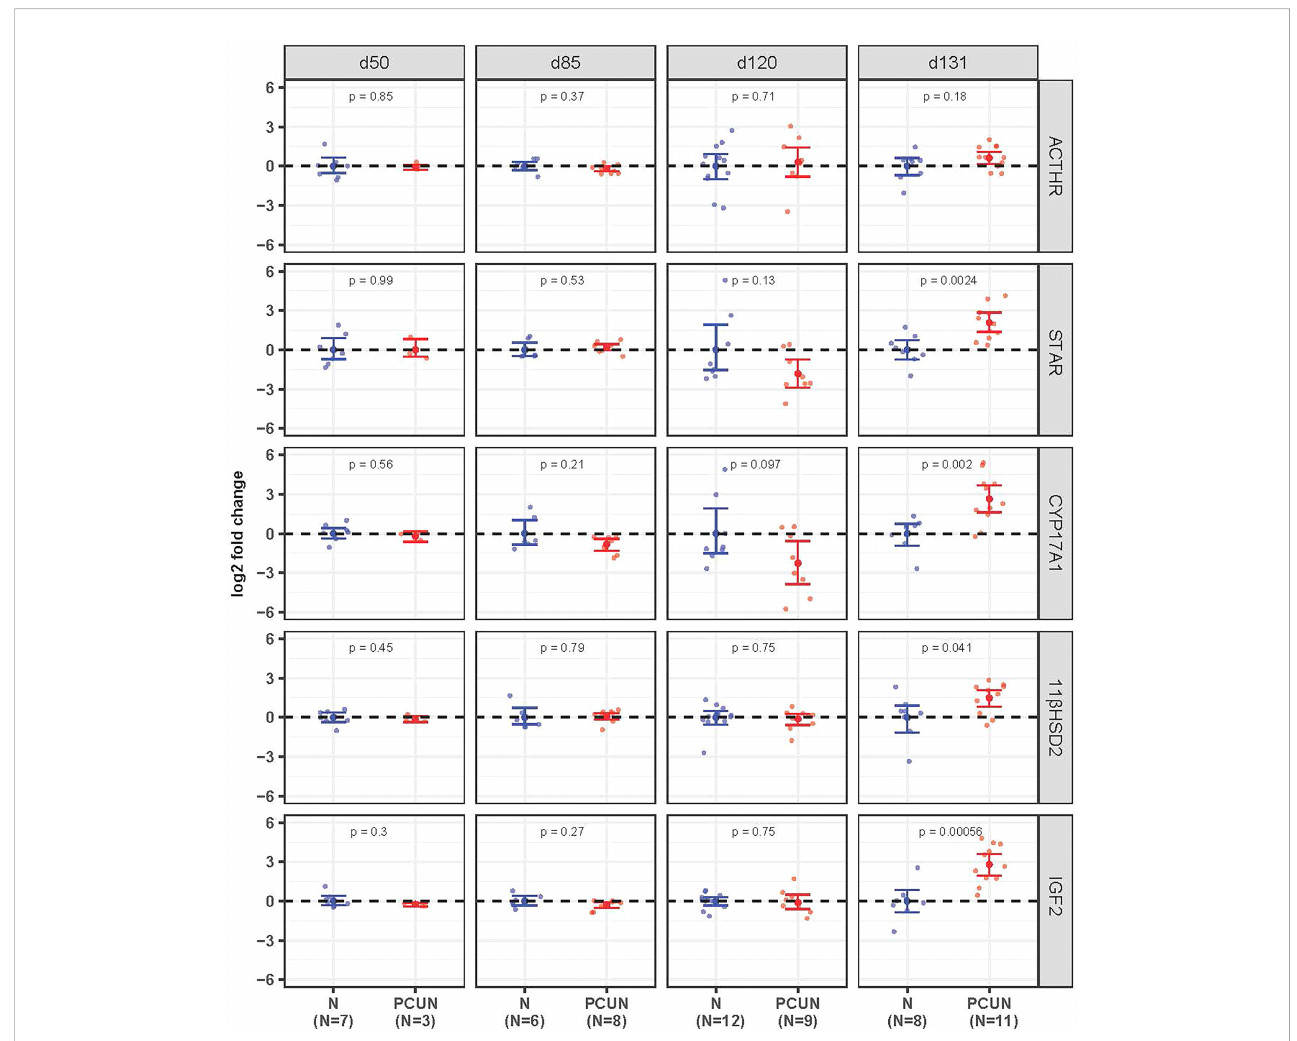
FIGURE 3 Fetal adrenal mRNA expression. Log 2 fold change of ACTHR , STAR , CYP17A1 , 11 b HSD2 , and IGF2 mRNA expression levels in PCUN (symbol in red) in comparison to N (symbol in blue) based on real-time PCR analysis in the fetal adrenal. Data are shown as mean ± 95% con fi dence interval. Symbols represent individual animals. Student ’ s t-tests were used to assess statistical difference, with signi fi cance de fi ned as p <